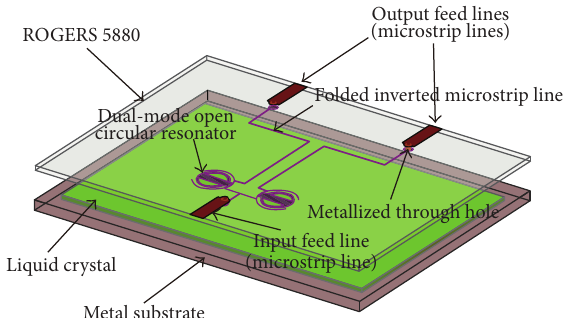
Figure 2: Schematic of continuous adjustable band-pass filter integrated power divider.